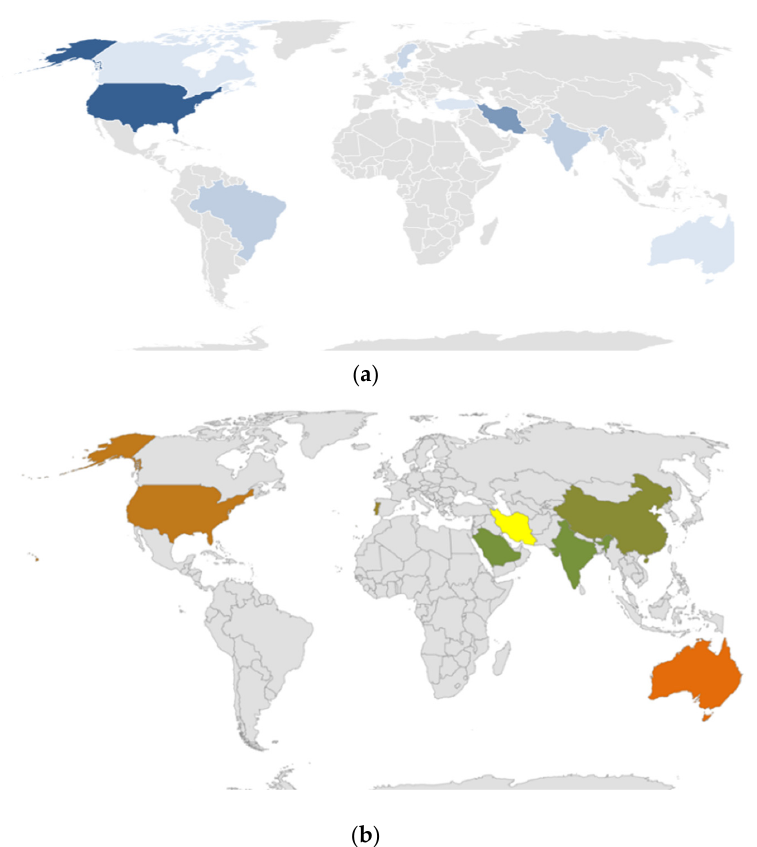
Figure 3. ( a ): Geographic distribution of the top 50 most-cited articles in WMSDS using RULA in regard to healthcare practitioners. ( b ): Geographic distribution of the top 50 most-cited articles in